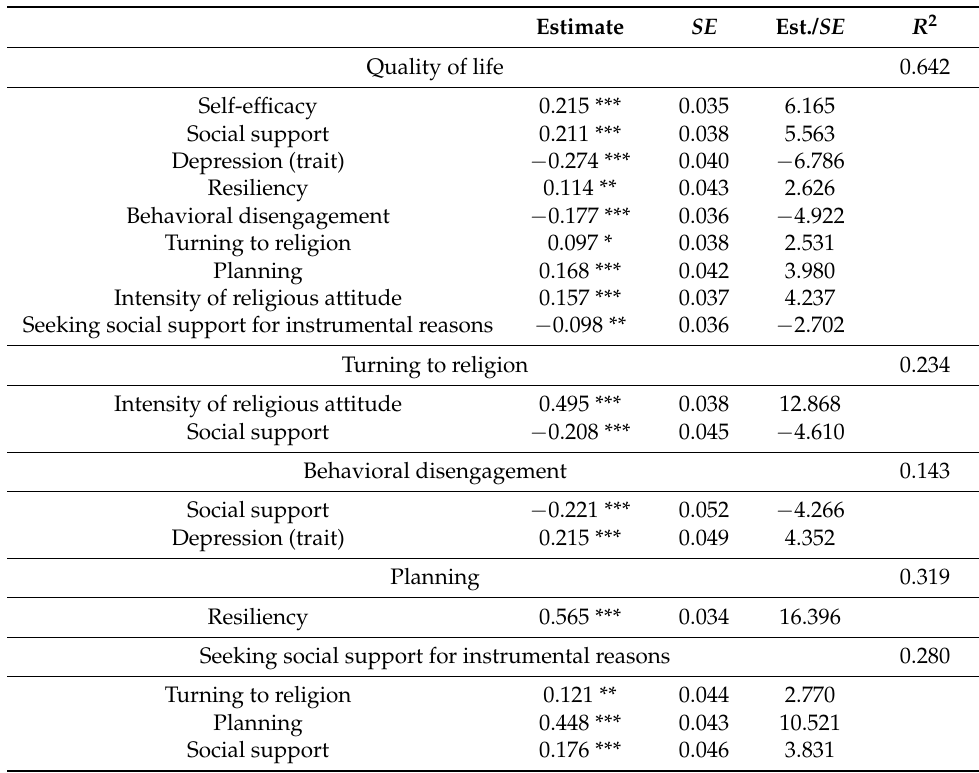
Table 5. Results depicting the relationships observed among the study variables included in the